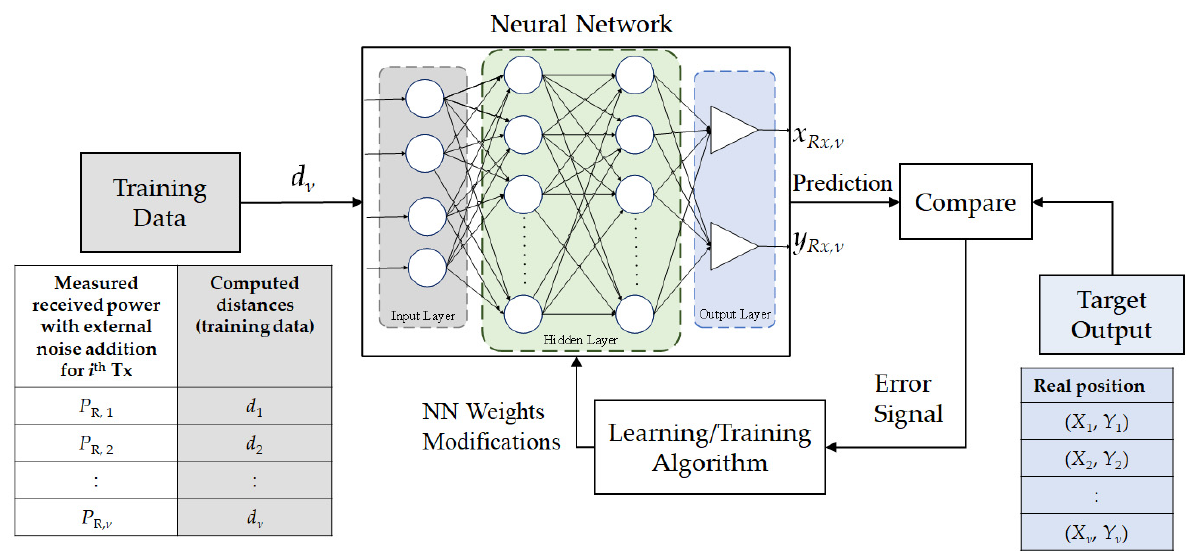
Figure 5. The layout of the neural network used with four layers. Table 2. Total dataset samples considered for the proposed ANN.